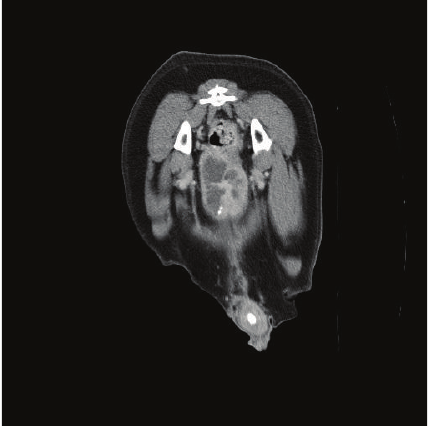
Figure 2: CT image of the prostate gland obtained prior to chemo- therapy and radiotherapy. Note the prostatic enlargement and